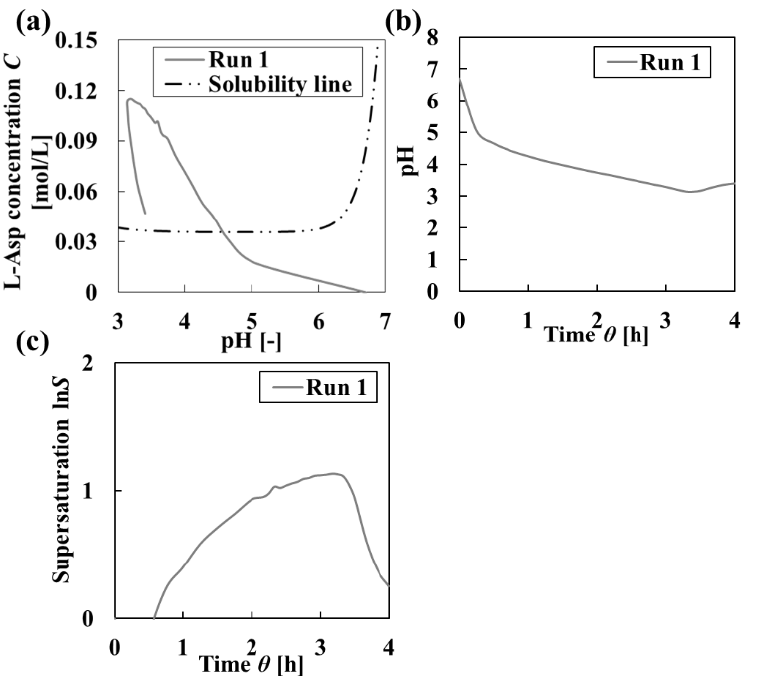
Figure 3. Changing in the solution condition during crystallization under Run 1. ( a ) L-Asp concen- tration to pH. ( b ) Solution pH. ( c ) Supersaturation calculated from ( a ).